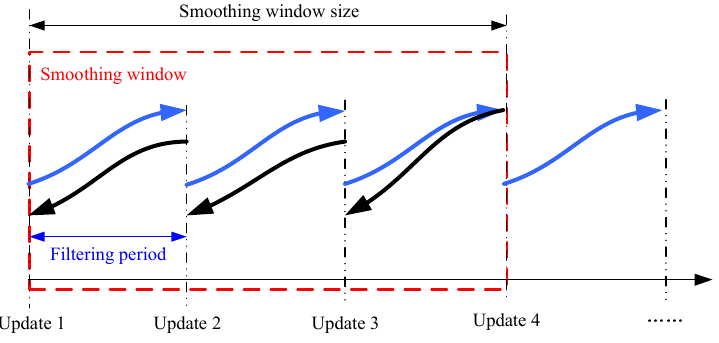
Figure 8. The relation between the smoothing window size and the filtering